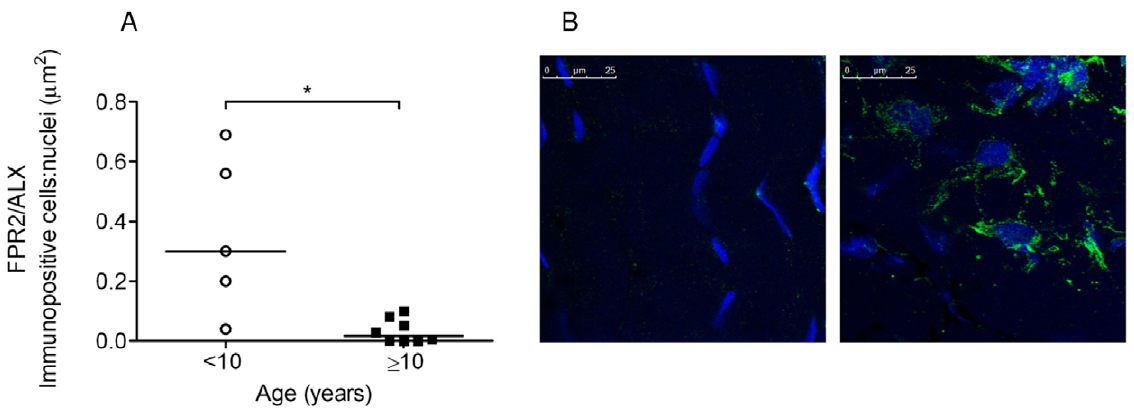
Figure 7. FPR2/ALX protein expression in tendon explants invitro . (A) FPR2/ALX protein expression is shown for IL-1 b stimulated macroscopically normal tendon explants derived from horses , 10 years of age (n=5) or $ 10 years of age (n=8). There was significantly greater FPR2/ALX expression by tenocytes in IL-1 b stimulated explants from horses less than 10 years of age compared to older horses ( P =0.01). Data represent average FPR2/ALX expression whereby 2 replicates were analysed per horse and median values are shown. (B) Panel of representative 2- dimensional confocal images illustrating FPR2/ALX expression in tendon explants from a 4 year old horse showing non-stimulated control (left) compared to stimulation with 5 ngml 2 1 IL-1 b (right). FPR2/ALX expression was not detectable in non-stimulated controls. Immunopositive staining is green, with Hoechst nuclear counter stain in blue. Scale bar=25 m m.